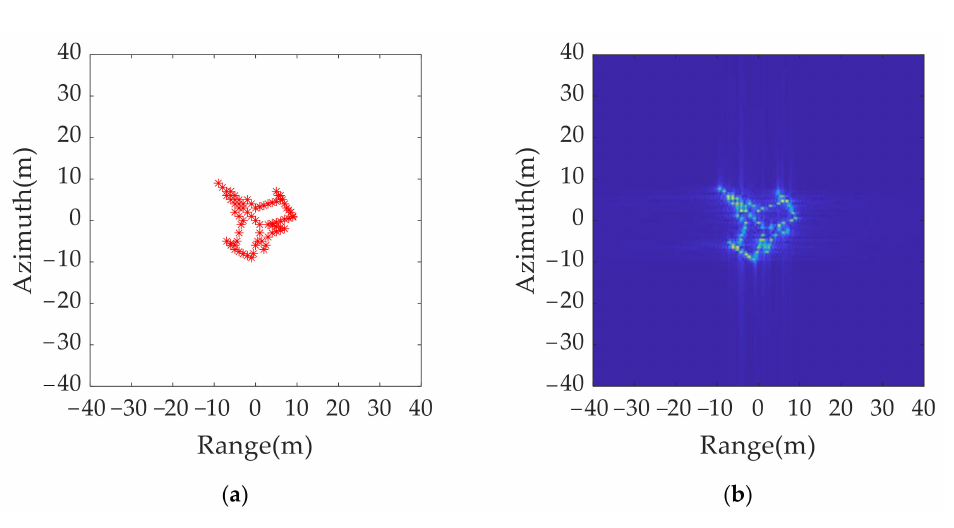
Figure 14. Simulated multiple points model: ( a ) aircraft model of 74 points; ( b ) ISAR imaging without